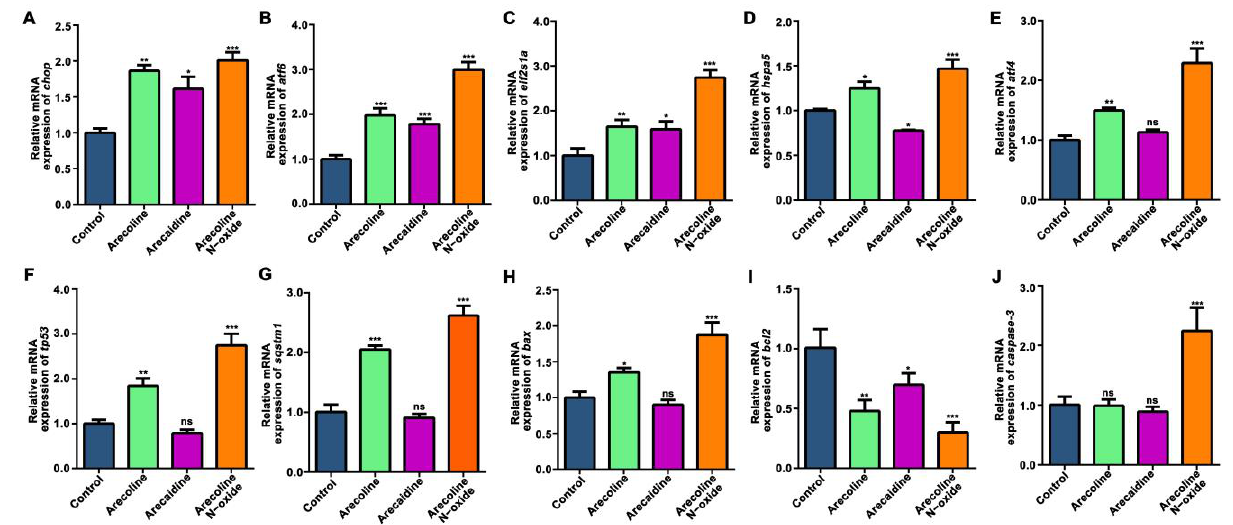
Figure 7. The mRNA expression levels of genes related to ER stress and the apoptosis p53 signaling pathway. The expression levels of genes related to ER stress ( A – E ) and the p53 signaling pathway ( F – J ) in zebrafish at 96 hpf. Values are presented as the mean ± SD ( n = 3). Asterisks denote significant differences between treatments and the control (*, p < 0.05; **, p < 0.01; ***, p < 0.001, ns means no